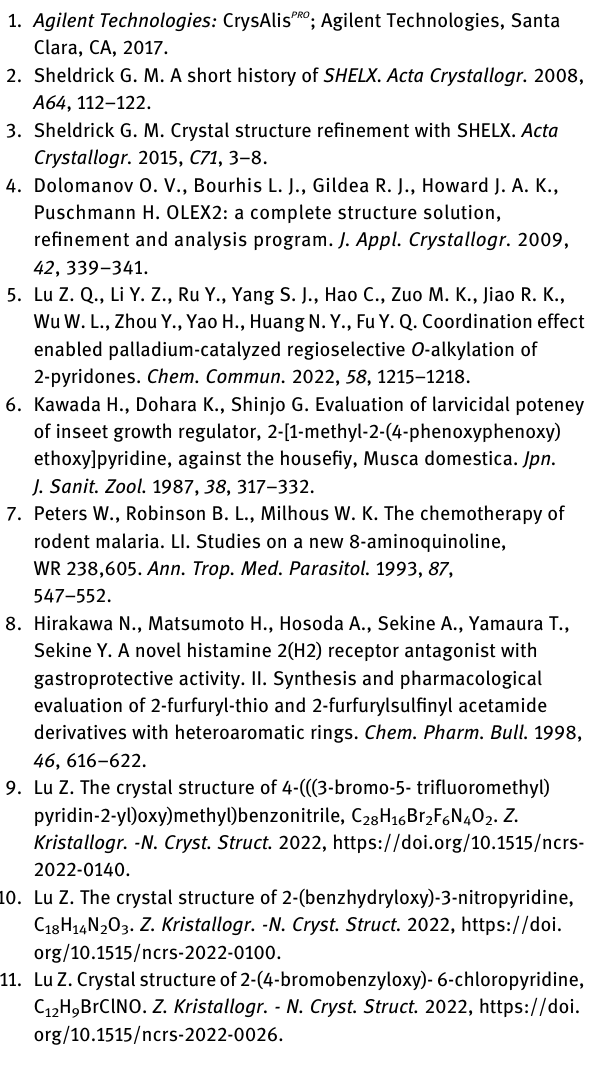
one crystallographically independent molecule in the asymmetric unit (see the fi gure). All bond lengths and angles are in the expected ranges. The title compound consists of one cyanophenyl and a pyridyl moiety, and the dihedral angle between the two planes is 48.1 ° .